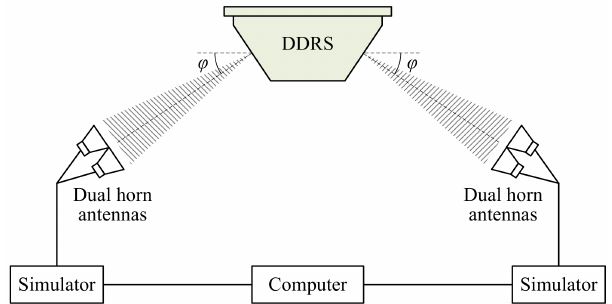
Figure 8. Block diagram of dual Doppler shift simulation system for the